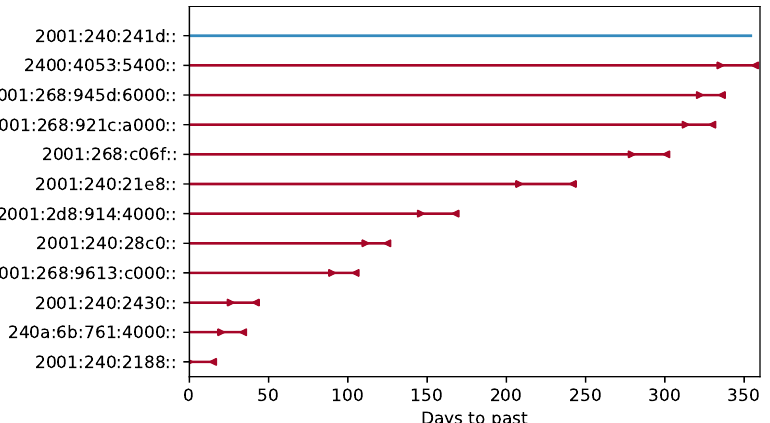
Figure 9. Sample interval censoring of IPv6 address location lifetime. First addresses of IP blocks are shown.